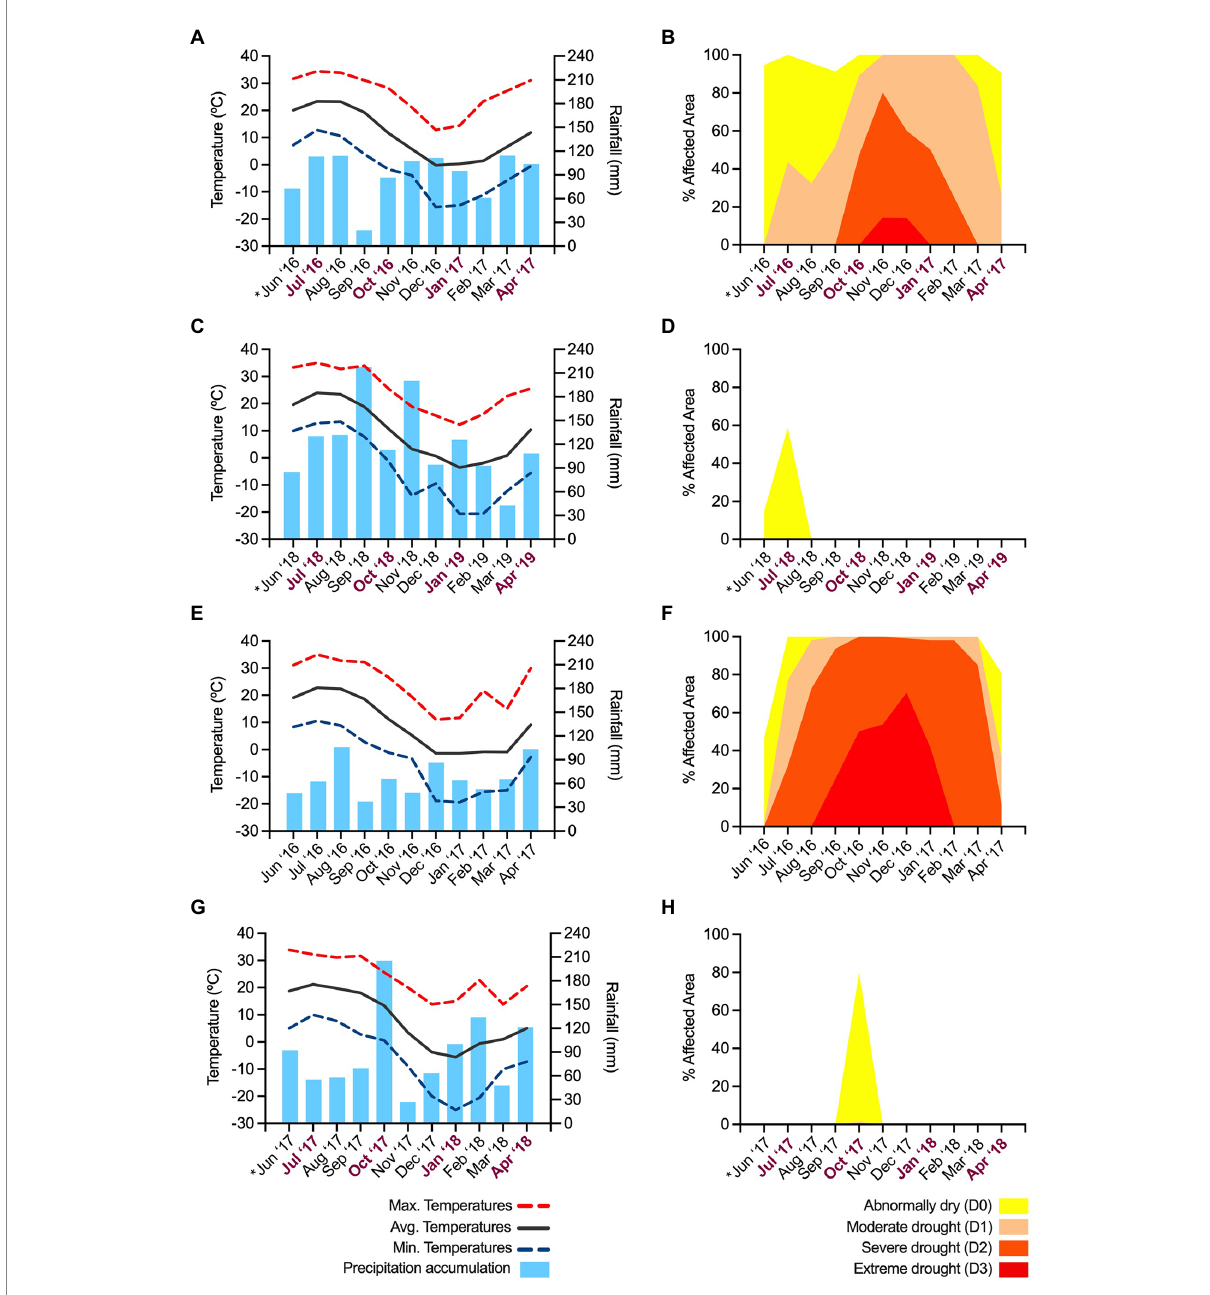
FIGURE 1 Summary of the environmental conditions during the assays. The first experiment repeat was performed in Highland, NY, during 2016–2017 (A,B) . The second experiment repeat with apple trees was carried out in the same orchards (C,D) in 2018–2019. The second repeat of the assays with pear and Asian pears was performed in (Belchertown, MA), in 2017–2018 (G,H) . The environmental conditions in Belchertown in 2016–2017 are also provided as a reference to compare conditions between the two locations during similar periods (E,F) . Charts on the left illustrate a monthly estimation of the maximum, average and minimum temperatures and the accumulated rainfalls during the 10-month assays. Data for graphs were retrieved from the SC-ACIS web service (https://scacis.rcc-acis.org). Because of the lack of complete data from the meteorological station in Highland throughout the two experiment repeats (2016–2019), the reported data are from the closest town (6.6 Km away) with fully available data, Poughkeepsie, NY, with similar elevation, latitude, and longitude coordinates as Highland. Charts on the right show an average monthly estimation of the intensity of the drought conditions and percent of the affected area in Ulster and Hampshire counties, where Highland (B,D) and Belchertown are located (F,H) . Drought graphs were created using data downloaded from the US drought monitor webpage (https://www. drought.gov). The X -axis of graphs A-D, G and H includes the timeline of the assays, and indicates the month in which tree inoculations were performed (*) and the points in which cankers were sampled (bold, purple